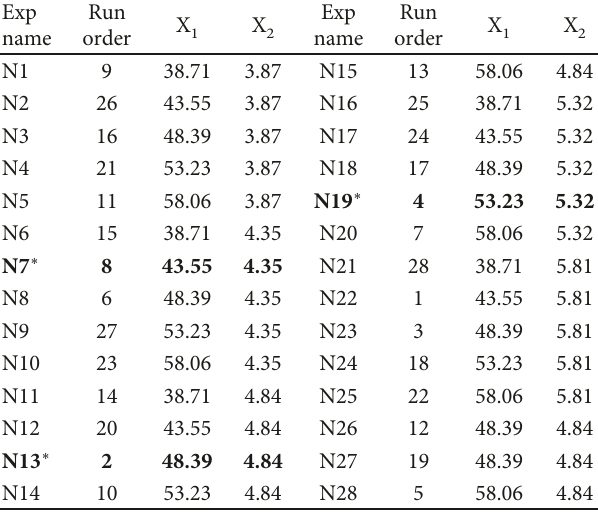
Table 2: Experimental design matrix for calibration set. Exp